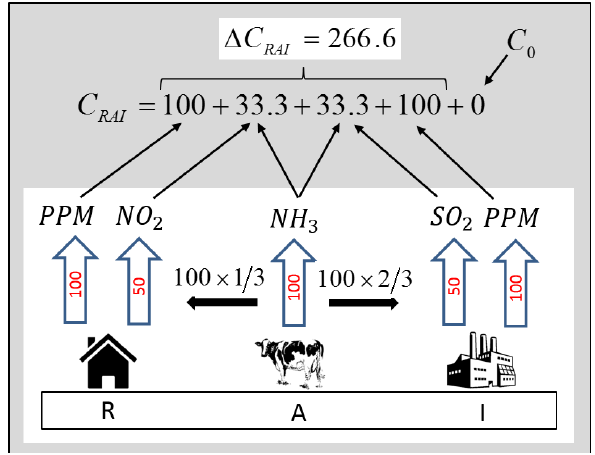
Figure 4. Example with three sources in an ammonia-limited regime. The mass emitted by each source is expressed in moles.